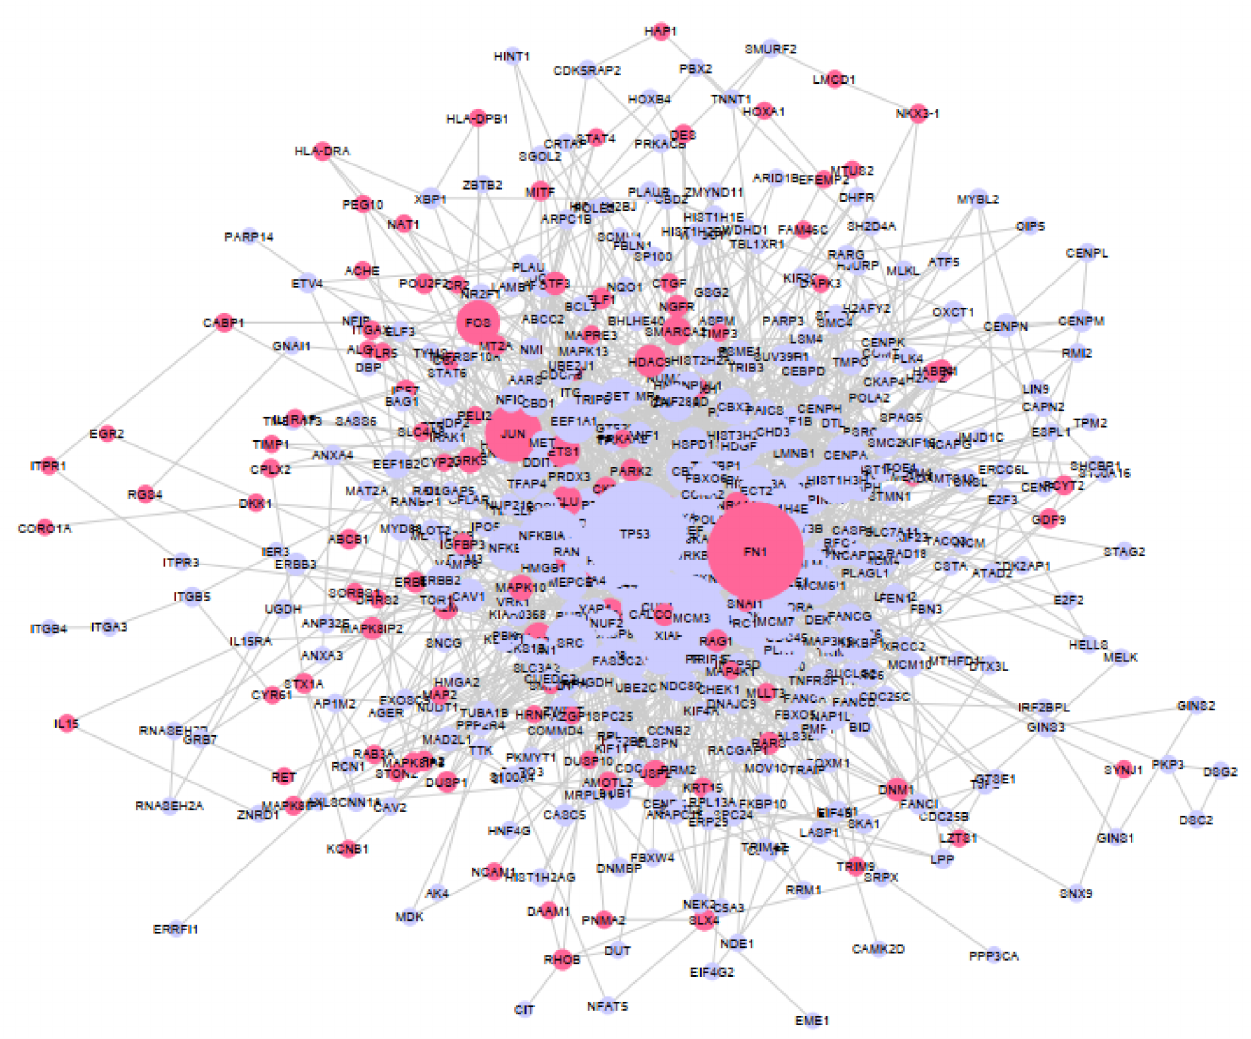
Figure 3. Functional enrichment analysis and network construction. Protein–protein interaction (PPI) network analyzed using NetworkAnalyst and constructed using Cytoscape software. Pink nodes represent the upregulated protein-coding genes, and purple nodes represent the downregulated protein-coding genes. Solid gray lines are edges and represent direct protein–protein interactions between two nodes. The size of the nodes is proportional to the number of interactions with other nodes, i.e., degree